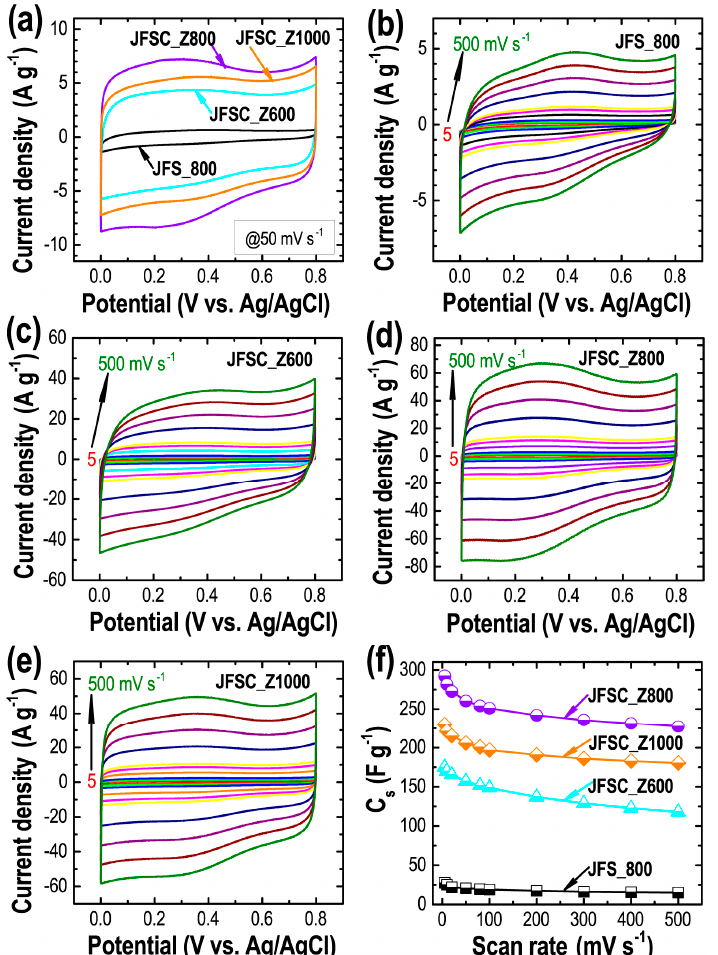
Figure 5. ( a ) Comparison of cyclic voltammetry (CV) profiles of all the derived nanoporous carbons at fixed scan rate 5 mV·s − 1 , and the CV profiles at different scan rate 5-500 mV·s − 1 . ( b ) JFS_800, ( c ) JFSC_Z600, ( d ) JFSC_Z800, and ( e ) JFSC_Z1000. ( f ) Calculated specific capacitance vs. scan rate for all